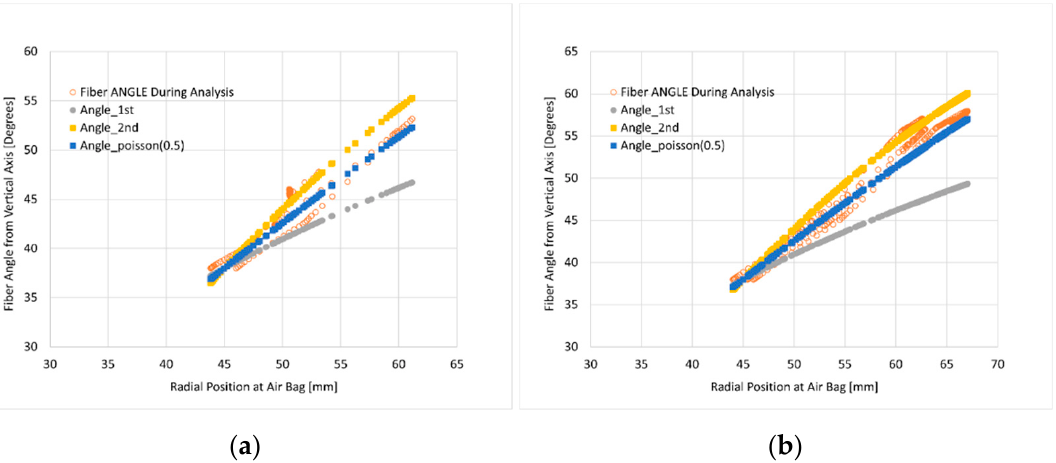
Figure 8. Angle calculation results and simulation results during inflation and compression analysis in sleeve-type air spring: ( a ) 2 outer points; ( b ) 3 middle points.